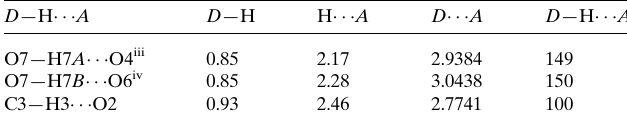
Table 2 Hydrogen-bond geometry (A˚ , (cid:5) ). D —H (cid:3)(cid:3)(cid:3) A